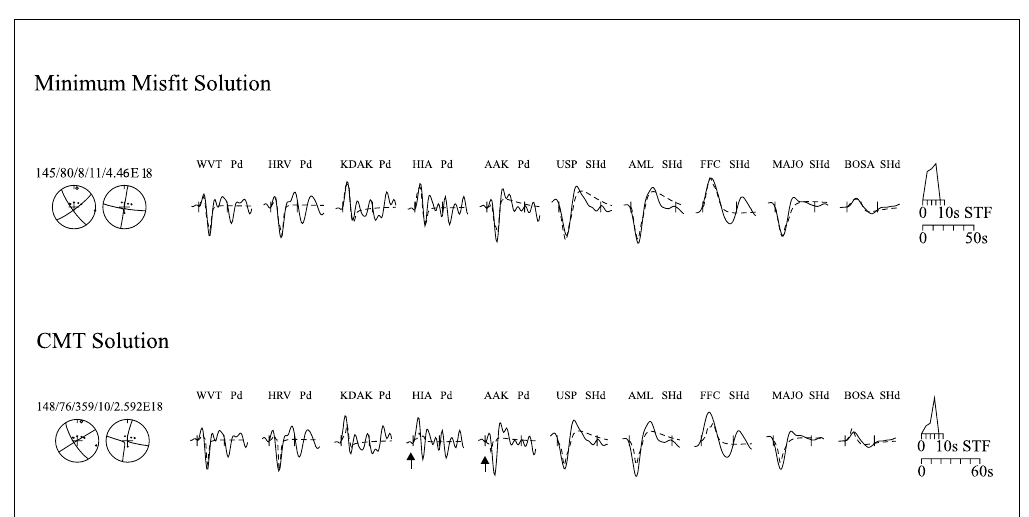
Fig. 3. Comparison of the «minimum misfit solution» obtained in this study (upper part) to the Harvard CMT solution (lower part). The solutions are not very different but our solution gives a considerably better fitting (HIA and AAK for